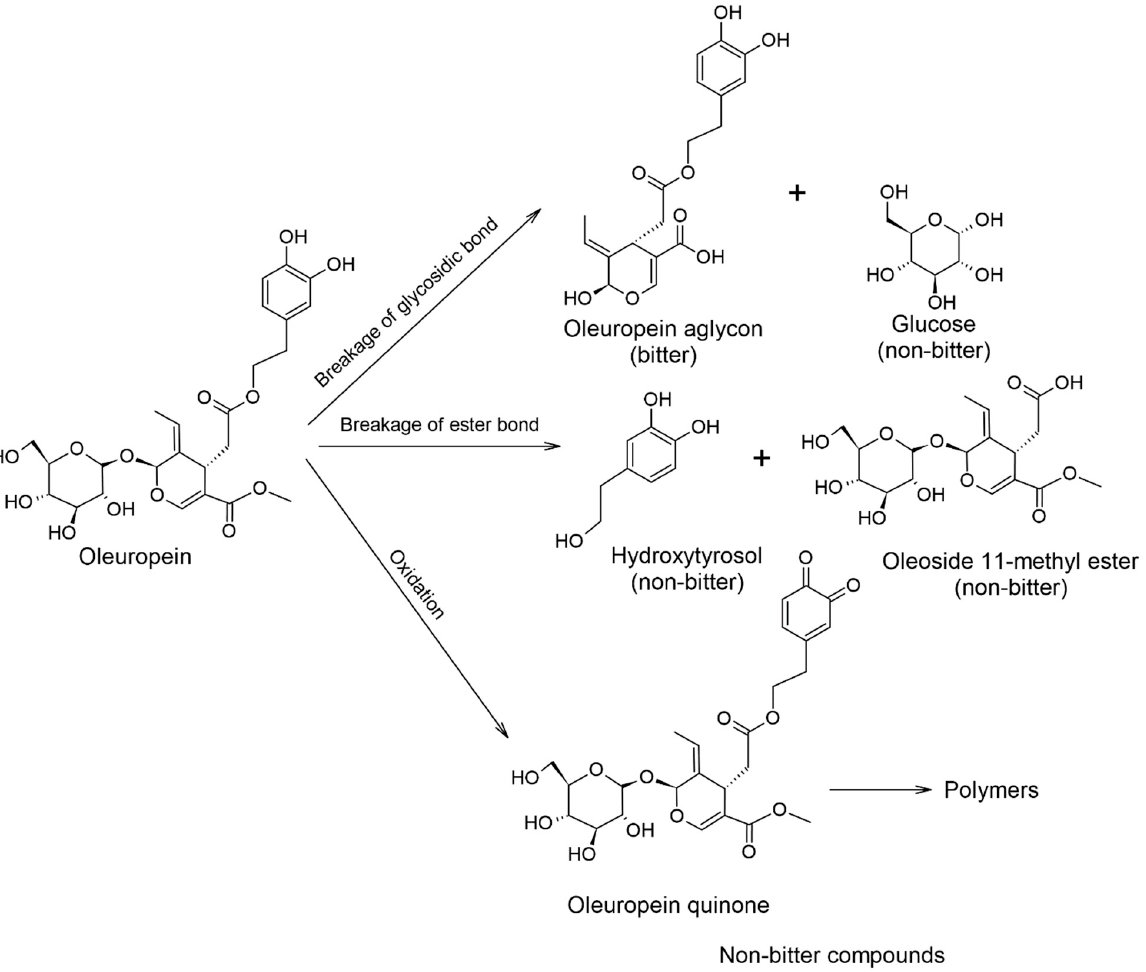
Scheme 1. Bitterness of oleuropein and products of its chemical transformations. Addapted